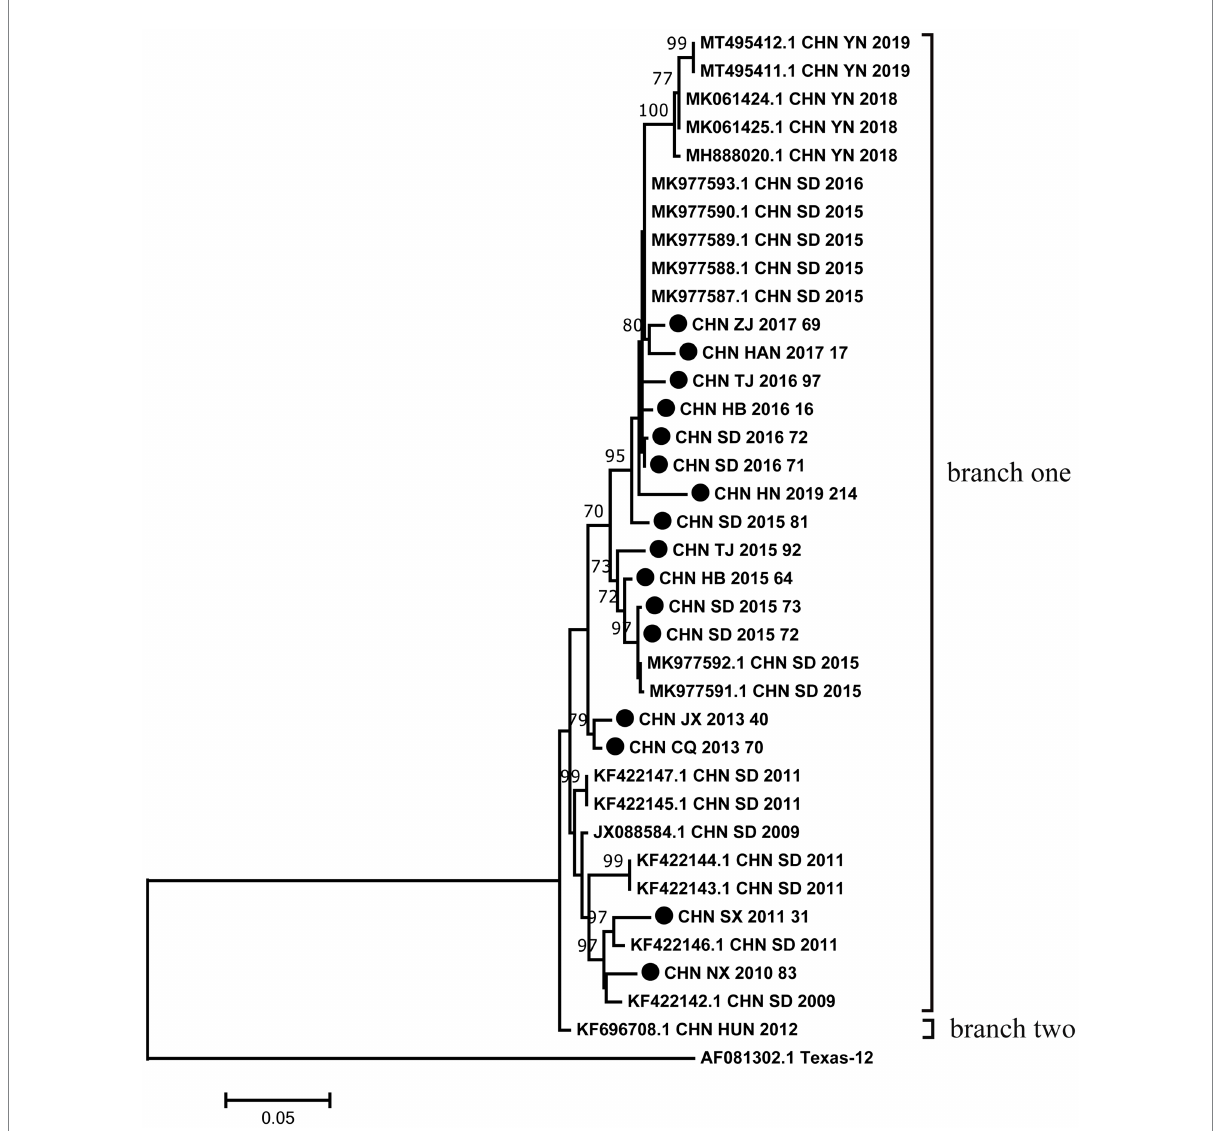
FIGURE 1 Phylogenetic analysis based on the full-length VP1 sequences of 16 CVA12 from this study and 21 sequences retrieved from the GenBank. Bootstrap values greater than 70% were highlighted. The 16 CVA12 strains from this study are represented by black